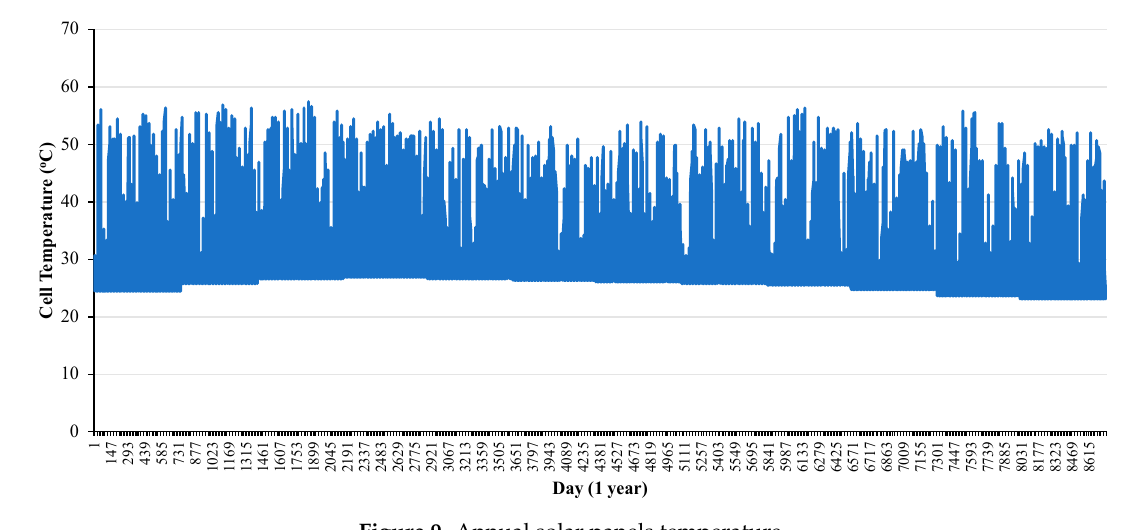
Figure 8. Annual solar irradiation of the case study area.